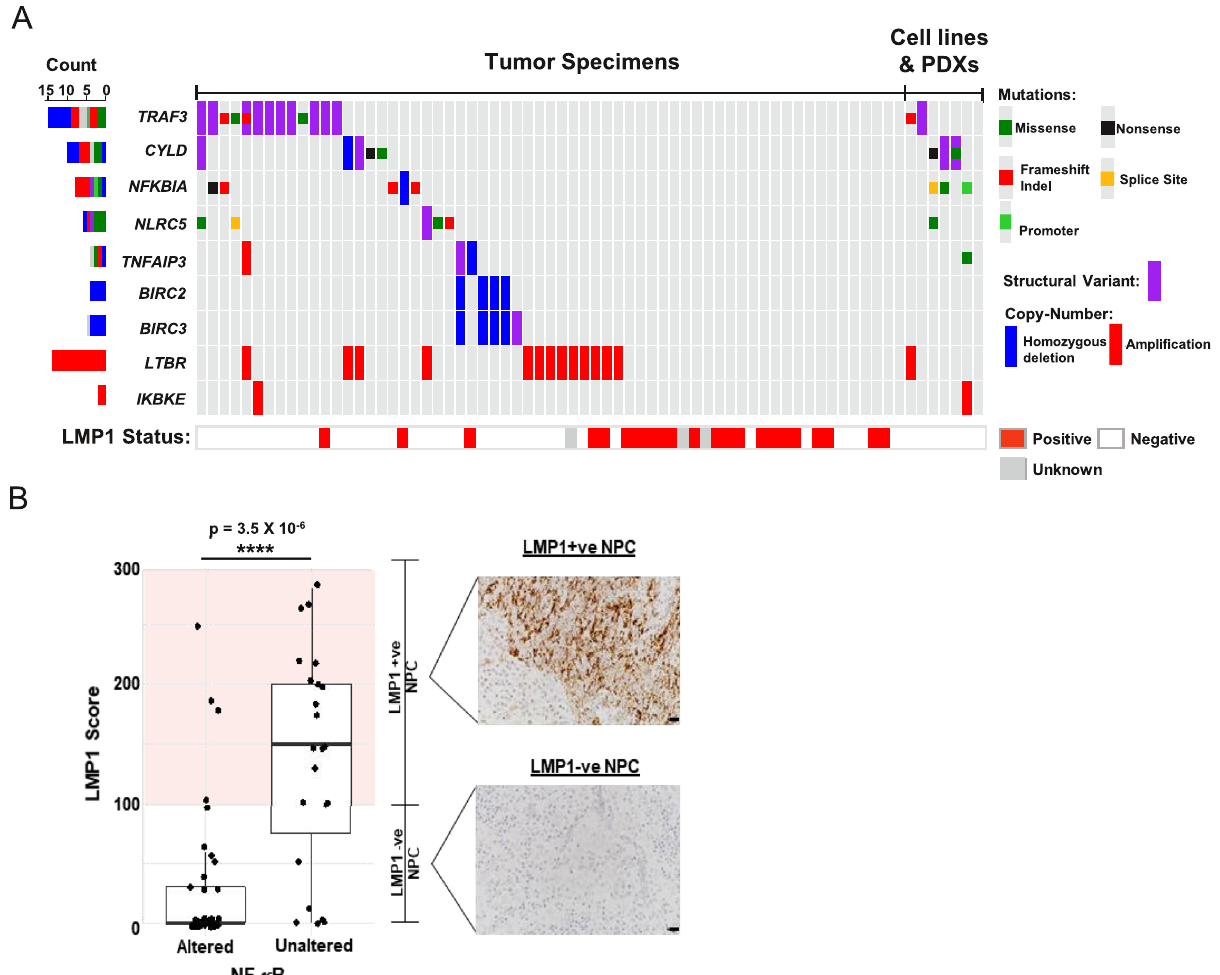
Fig. 3 Aberrant NF- κ B pathway activated by somatic gene alterations and EBV latent gene. A Somatic aberrations activating NF- κ B and LMP expression in 70 NPC samples. NPC tumors with LMP1 overexpression are also indicated. B LMP1 overexpression and somatic aberrations activating NF- κ B pathway are mutually exclusive at the whole-genome level in NPC (two-sided Fisher ’ s exact test p = 3.5 × 10 − 6 , **** P < 0.0001). Boxplot is de fi ned as follows: center upper whisker = min(max(x), Q_3 + 1.5 * IQR), lower whisker = max(min(x), Q_1 – 1.5 * IQR); where IQR = Q_3 − Q_1, the bounds of the box. LMP1 expression was examined in NPC tumor specimens ( n = 65) by immunohistochemistry staining. IHC staining and scoring were performed twice in the tumors and similar results were observed. Representative images of NPC cases with high ( + ve) or absence/low ( − ve) LMP1 expression are shown. Scale bar: 10 μ m. Source data are provided as a Source Data fi